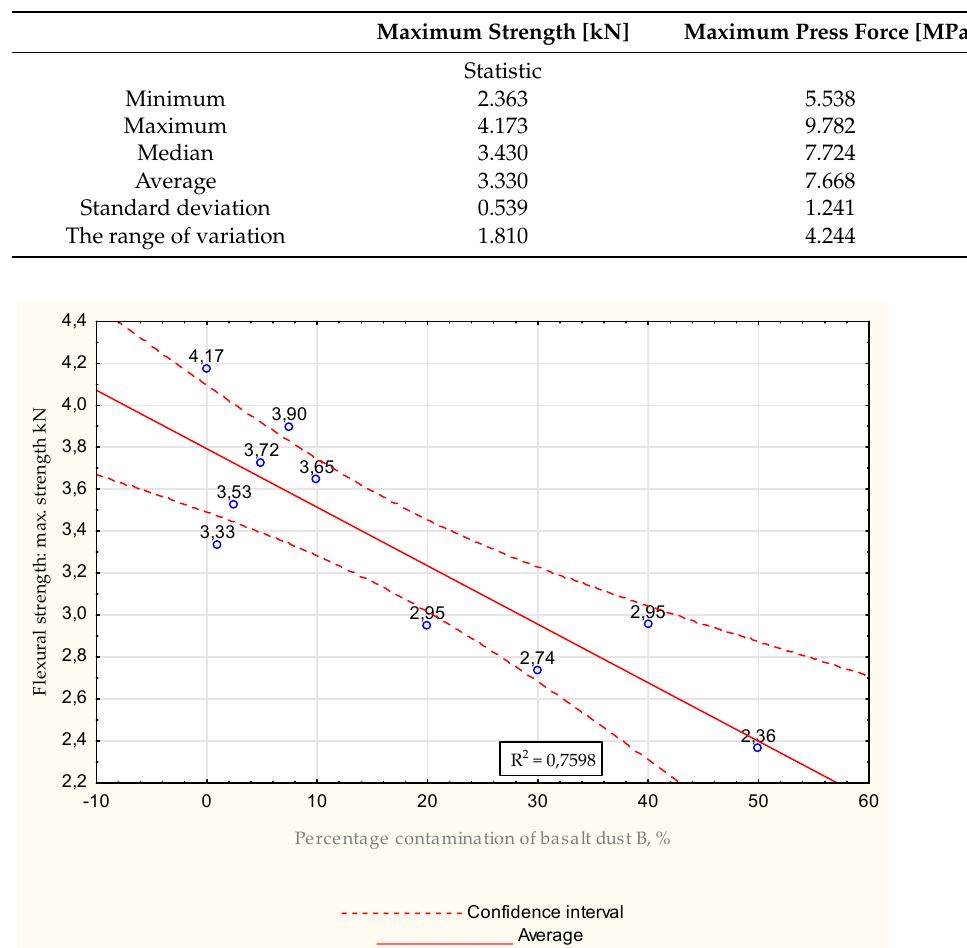
Table 17. Flexural strength tests for basalt dust B for all samples for water − mix ratio = 0.5 after 28 days.